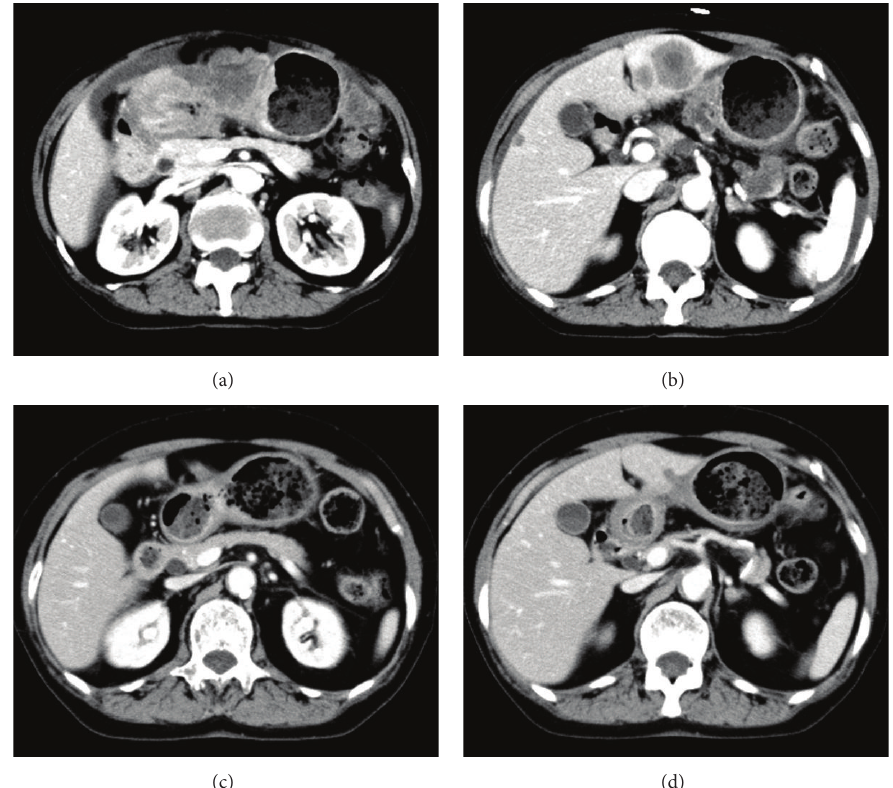
Figure 3: Contrast-enhanced computed tomography (CT) findings. (a) and (b) show the CT at presentation. (a) The wall of the lower part of the stomach is markedly thickened, and the density of the surrounding fat tissue is increased, forming an 80 × 45mm mass. (b) Two nodules are detected in the lateral segment of the liver, and these are directly contiguous from the gastric mass. (c) and (d) show the CT findings after completion of the 11th course of chemotherapy (capecitabine + CDDP + trastuzumab). (c) The gastric mass is markedly decreased. (d) Only a small nodule in the lateral segment of the liver is